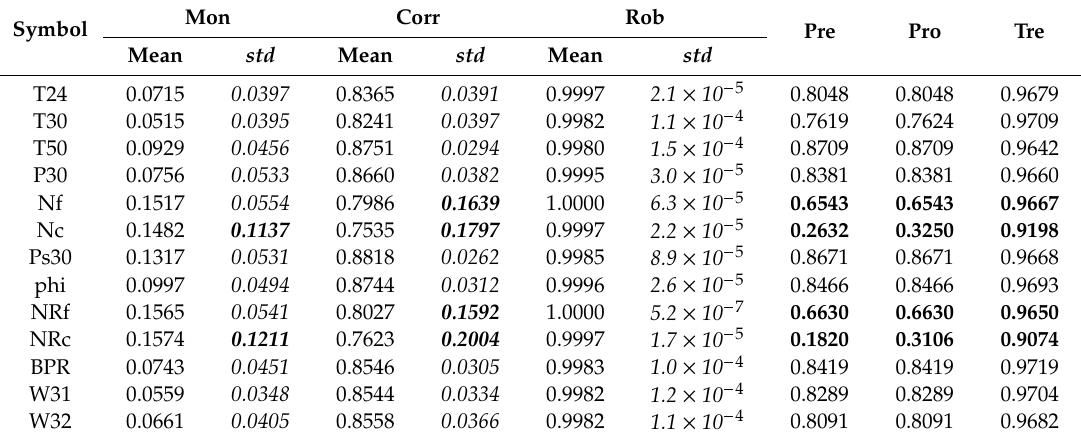
Table 2. Evaluation results of the sensors for the training data set of FD001. Abbreviations: Mon, monotonicity; Corr, correlation; Rob, robustness; Pre, predictability; Pro, prognosability; Tre,